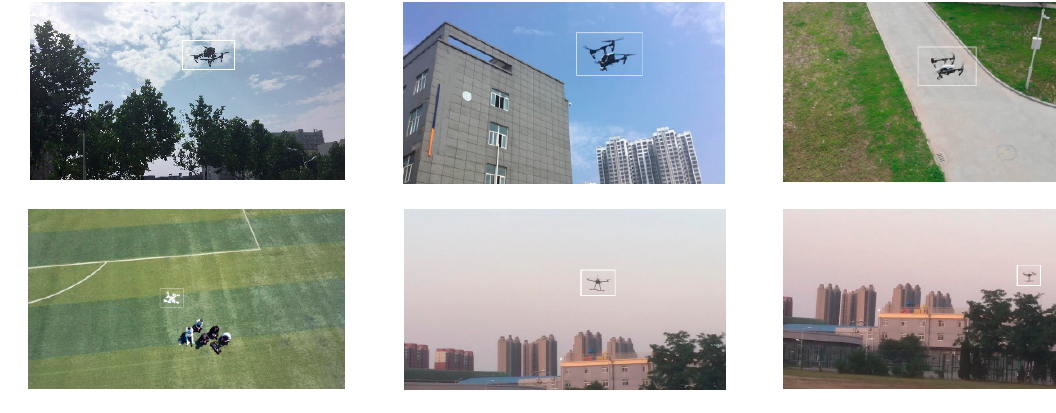
Figure 11. UAV detection results.